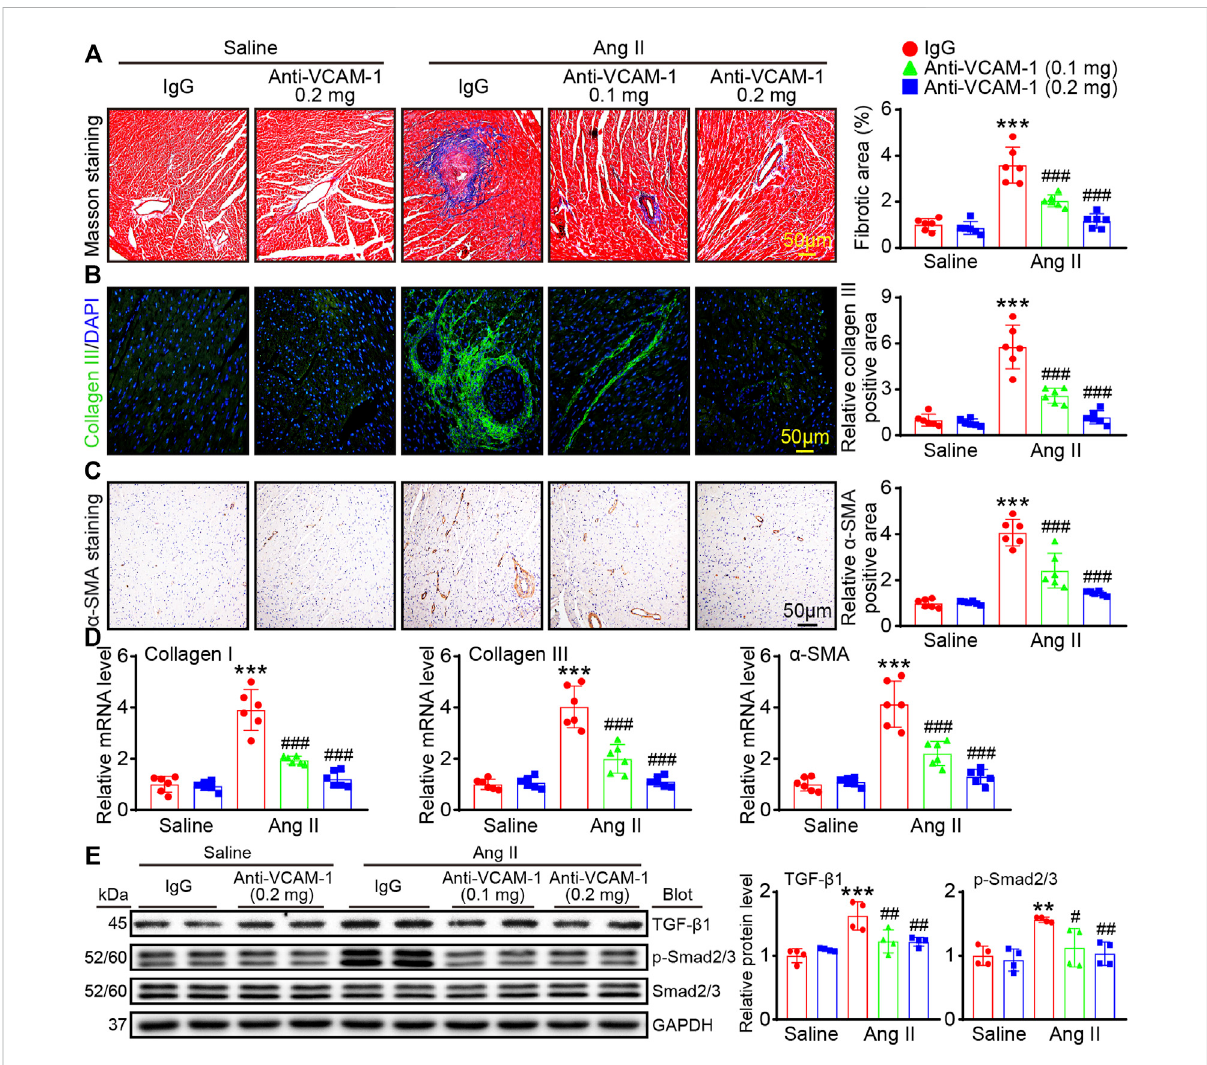
FIGURE 3 Blockade of VCAM-1 suppresses Ang II induced cardiac fi brosis. (A) Masson ’ s trichrome staining of heart sections (left). Scale bar: 50 μ m. Analysisofthe fi broticareas(right, n =6) (B) Immuno fl uorescencestainingofheartsectionswithananti-collagenIIIantibody(left).Scalebar:50 μ m. Analysis of collagen III positive areas (right, n = 6) (C) Immunohistochemical staining of heart sections with an anti- α -SMA antibody (left). Scale bar: 50 μ m. Analysis of α -SMA-positive areas (right, n = 6) (D) qPCR analysis of collagen I, collagen III and α -SMA expression in the heart ( n = 6) (E) Immunoblot analysis of TGF- β 1 and p-Smad2/3 (left) and analysis of the levels of these proteins (right, n = 4). The data are expressed as the M ± SD, and n represents the number of animals. ** p < 0.01 and *** p < 0.001 vs saline + IgG group. # p < 0.05, ## p < 0.01 and ### p < 0.001 vs Ang II + IgG